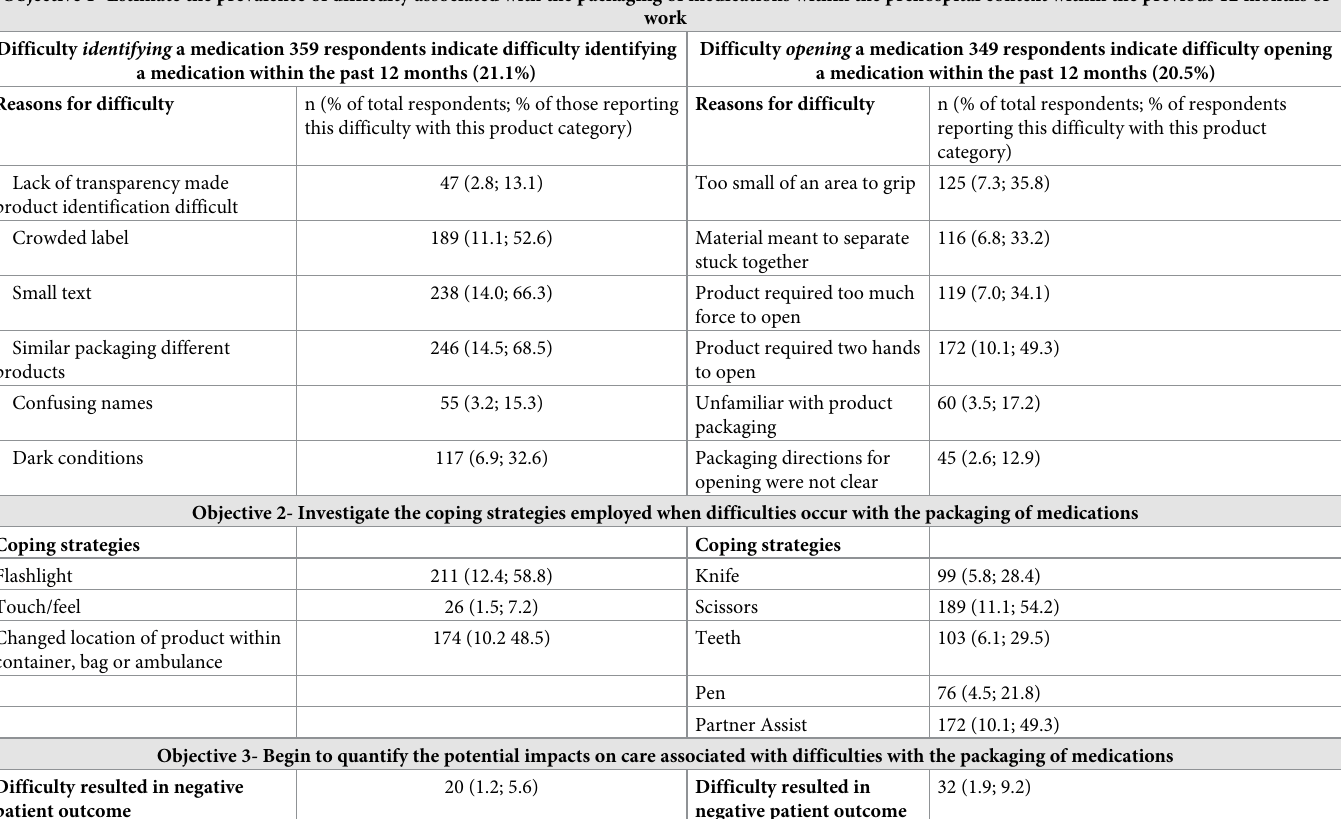
Table 3. Frequencies and proportion of respondents self-reporting difficulty with each task (identifying and opening), resulting coping strategies and negative impact on care related to medication use within the previous 12 months. Objective 1- Estimate the prevalence of difficulty associated with the packaging of medications within the prehospital context within the previous 12 months of work Difficulty identifying a medication 359 respondents indicate difficulty identifying a medication within the past 12 months